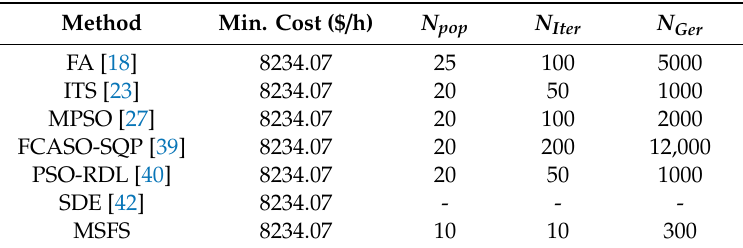
Table 6. Comparison of the implemented results for case 2.